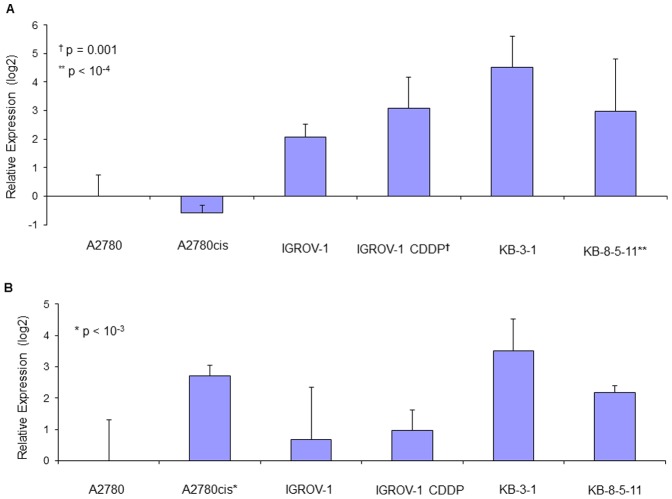
miR-21 (A) and miR-146a (B) expression in chemosensitive and chemoresistant cancer cells.Data are expressed as fold change in expression with respect to A2780 cancer cells (with standard deviation).